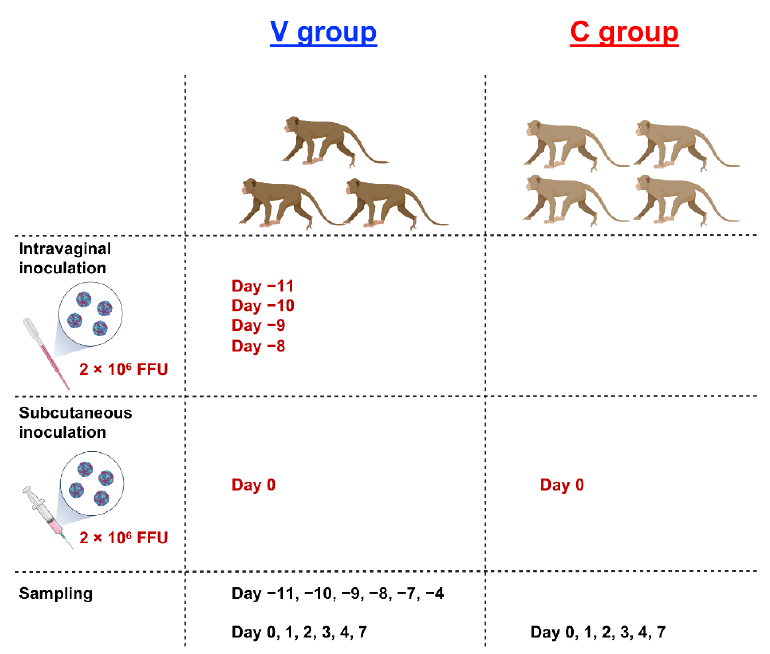
Figure 1. Schematic procedure of the in vivo experiment. Three female cynomolgus monkeys were intravaginally inoculated with the Zika virus (ZIKV) PRBABC59 strain on Days 8, 9, 10, and 11 (2 × 10 6 focus forming units (FFU) at each time point) prior to subcutaneous infection. Seven female monkeys, including these three animals, were subcutaneously challenged with the ZIKV PRBABC59 strain (2 × 10 6 FFU) on day zero.